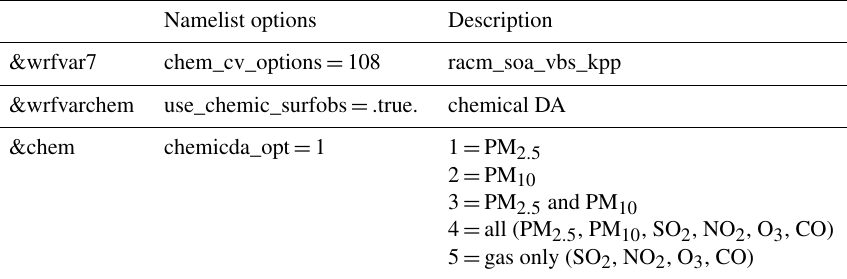
Table 2. A list of new namelist parameters in